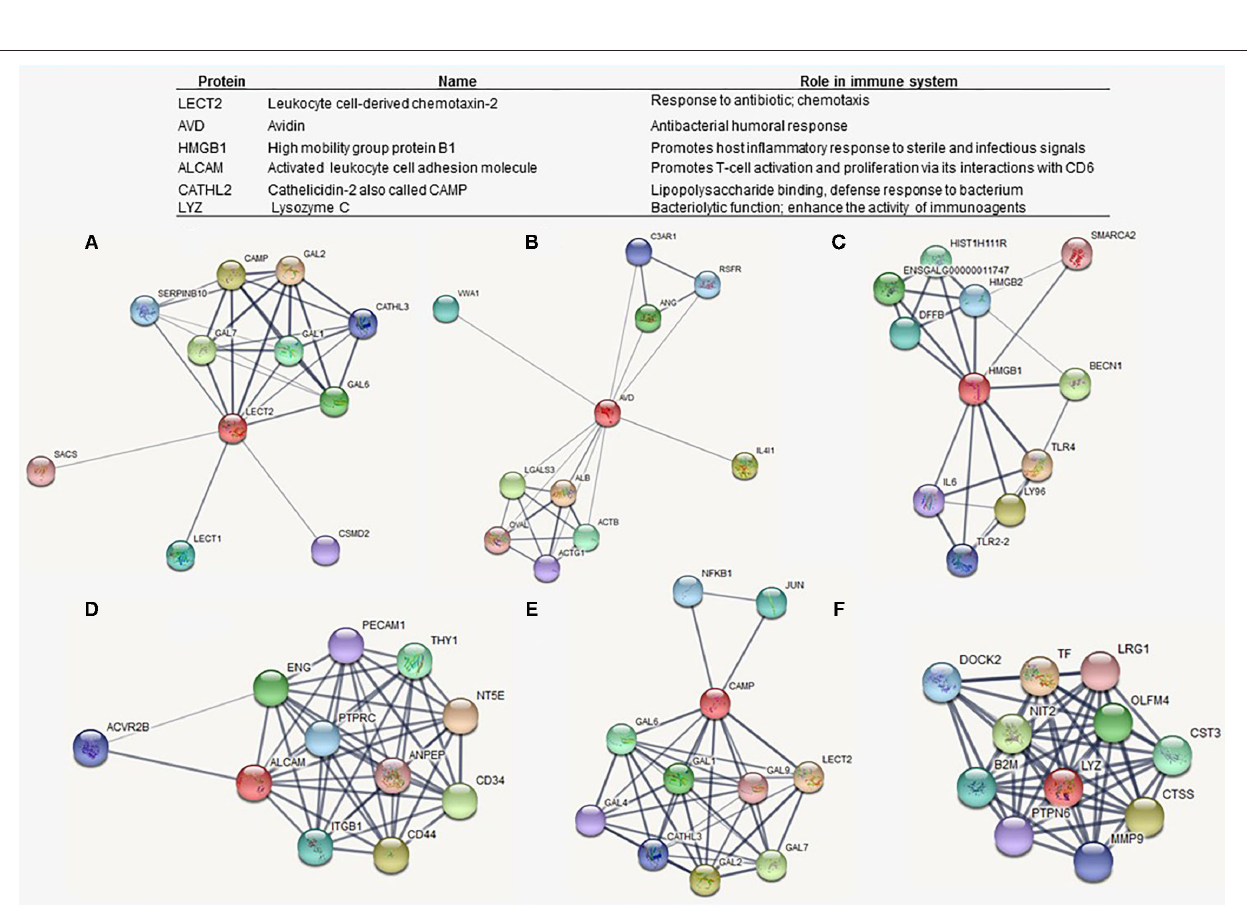
Frontiers in Physiology | www.frontiersin.org